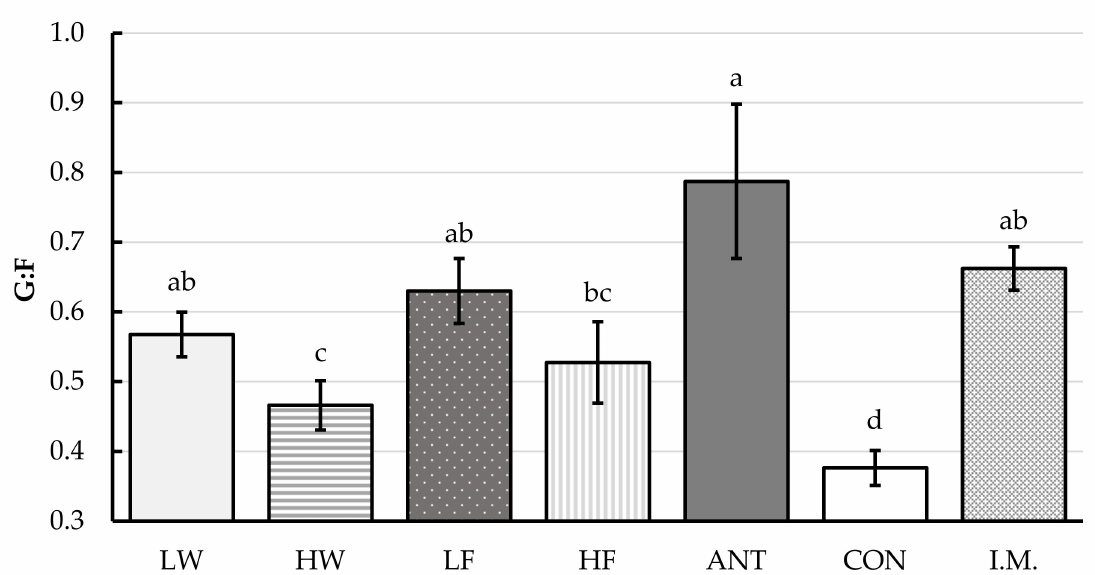
Figure 1. The impact of treatment, without regards to sex, on the gain-to-feed ratio (G:F). Values are least squares means ( ± largest SE) and represent the best estimate of mean based on repeated measurement analysis of variance. CON: control pigs received no treatment; I.M.: intramuscular injection